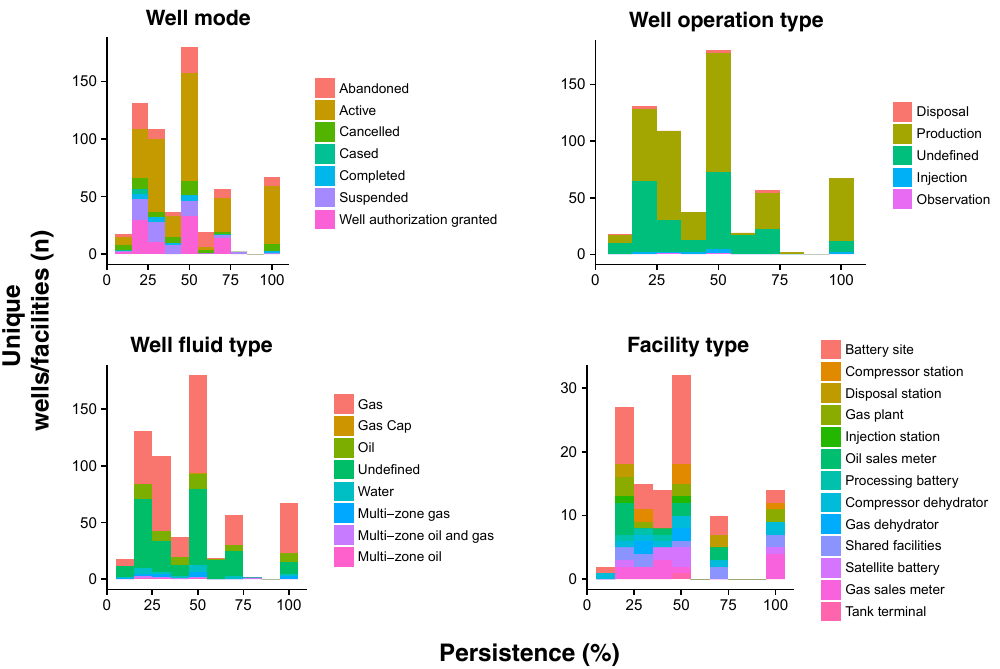
Figure 9. The cumulative number of unique wells/facilities versus emission persistence (%) across all 30 mobile surveys. Persistence refers to the repeated tagging of a piece of infrastructure as a possible emission source based on the method of plume attribution we applied in this study.